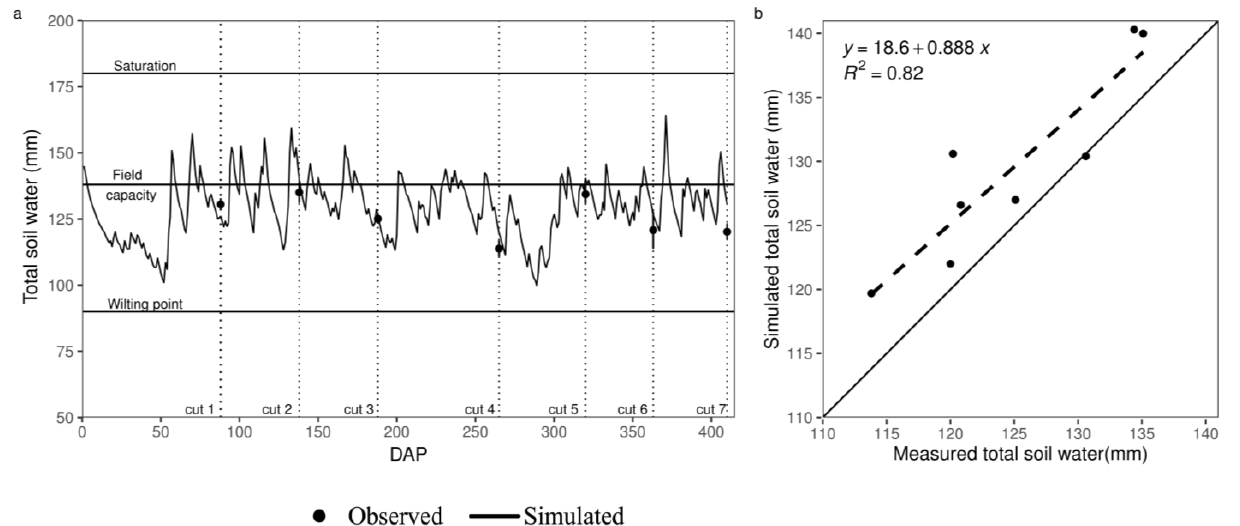
Figure 5. Simulated and observed values of total soil water (TSW) of 30 cm soil profile for the calibration treatment ryegrass ( Lolium perenne L.) during model calibration (C1-Irrigation: full irrigation treatment in the first cropping season of ryegrass). ( a ) Measured and simulated TSW during the growing season; ( b ) regression of measured and simulated TSW. Diagonal lines represent 1 ∶ 1 lines.